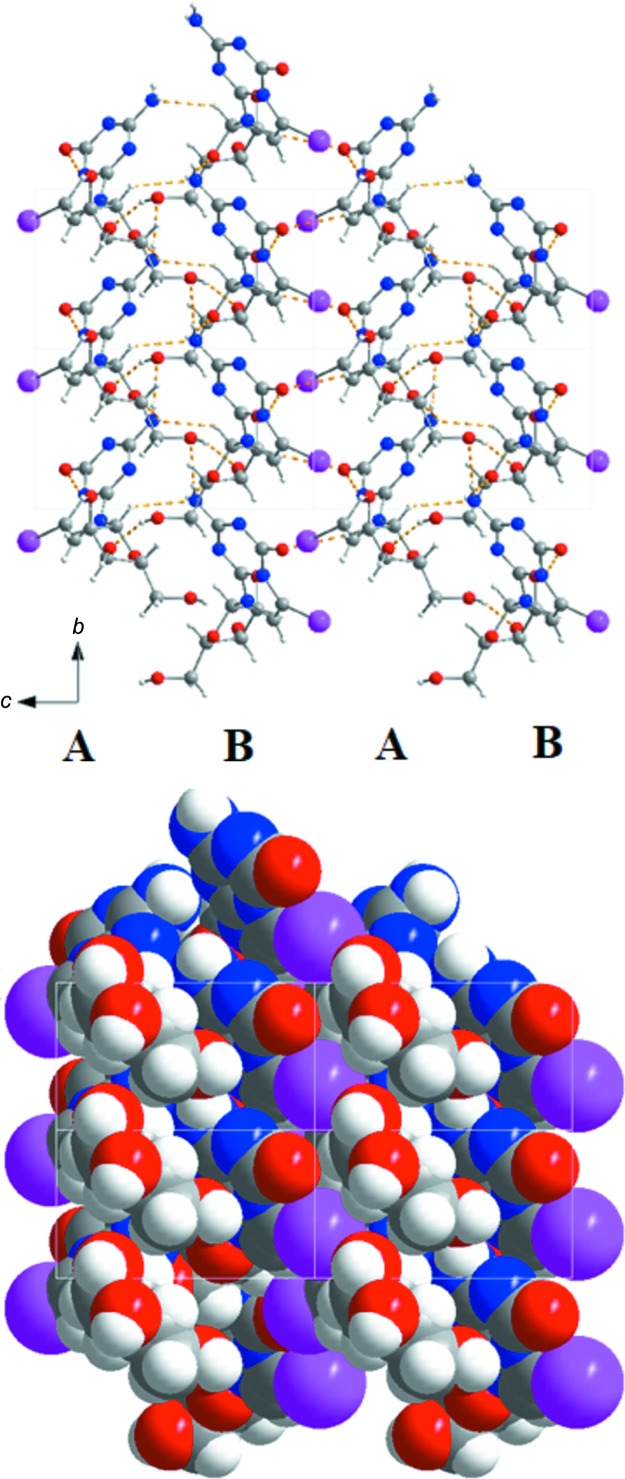
(Top) The crystal packing of 1, showing the hydrogen bonds along the a axis. (Bottom) Space-filling model of 1, viewed along the a axis.